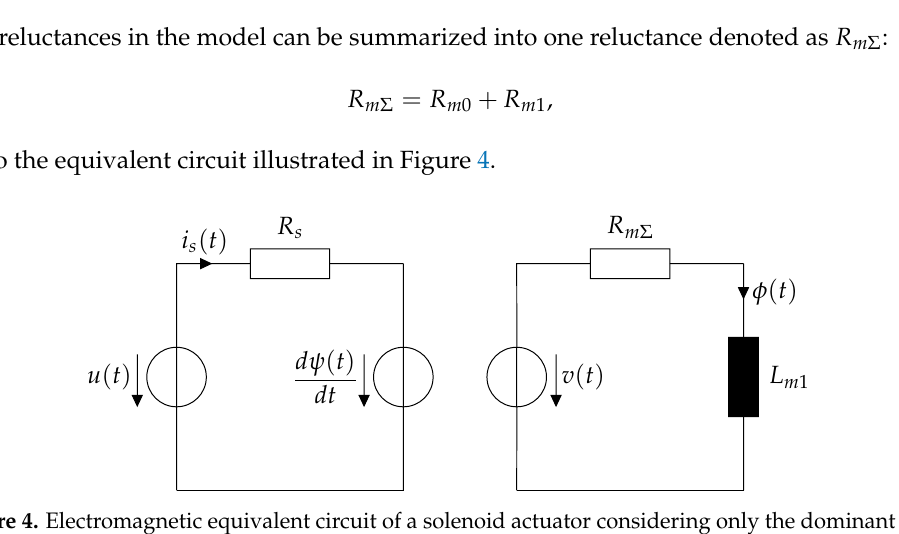
Figure 3. Approximation of the current ripple. Comparison between measured current ripple of the actuator ITS-LZ 1949 from Red Magnetics and the proposed models with different model complexity. Model accuracy is shown in percentage in comparison to the measured data.